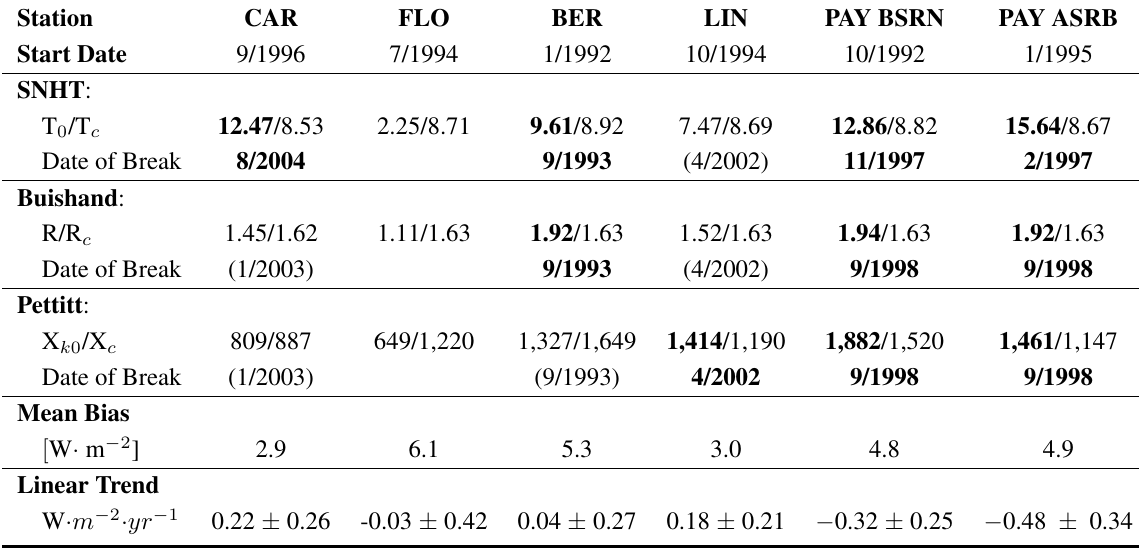
As in Table 4, but a relative analysis (compared to corresponding BSRN surface